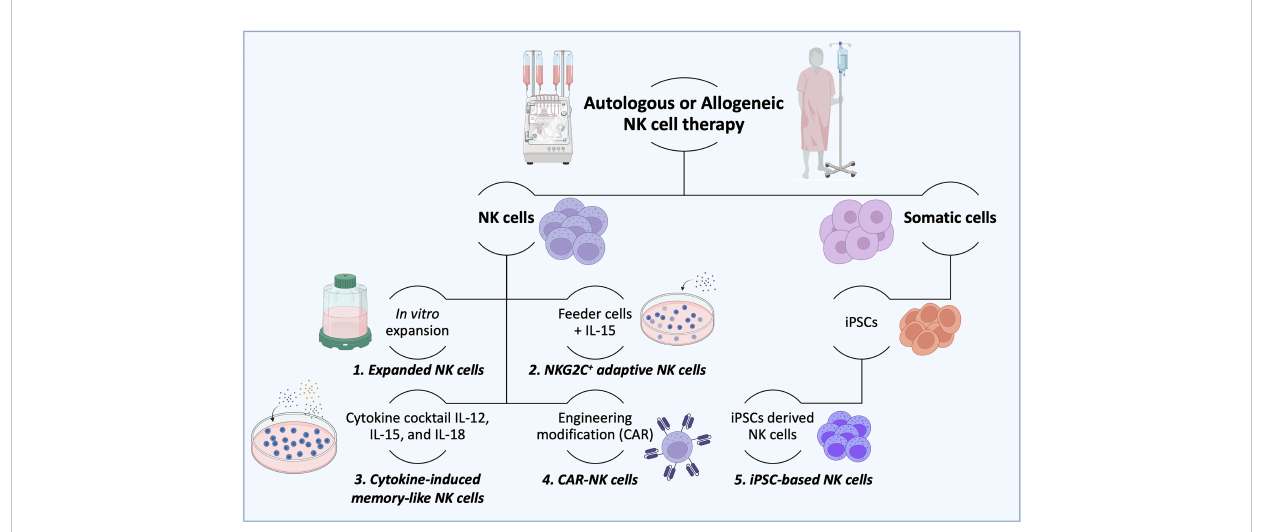
FIGURE 3 Production of therapeutic NK cells. For autologous or allogeneic clinical purposes, a considerable number of therapeutic NK cells are needed to destroy cancer cells effectively. To this end, several ways to obtain the desired number of therapeutic NK cells have been established. (1) After isolation, NK cells could be mass expanded in vitro in culture fl asks, reactors, and bags until the needed cell number is achieved. (2) Irradiated feeder cells (to suppress their expansion) in the presence of IL-15 are employed to stimulate the NK cell activation and expansion. (3) The combination of cytokines such as IL-12, IL-15, and IL-18 is used to expand NK cells and generate memory functions (memory-like NK cells). (4) NK cells can also be potentiated by engineering modi fi cations with CAR constructs to overcome their current limitations. (5) More recently, induced pluripotent stem cells (iPSCs) have been considered an advantageous source of NK and CAR-NK cells over peripheral and cord blood due to their usage in both autologous and allogeneic settings. (6) The IL-2-dependent immortalized NK-92 cell line is another type of NK cell source that possesses features of immune cell types and has been used in clinical